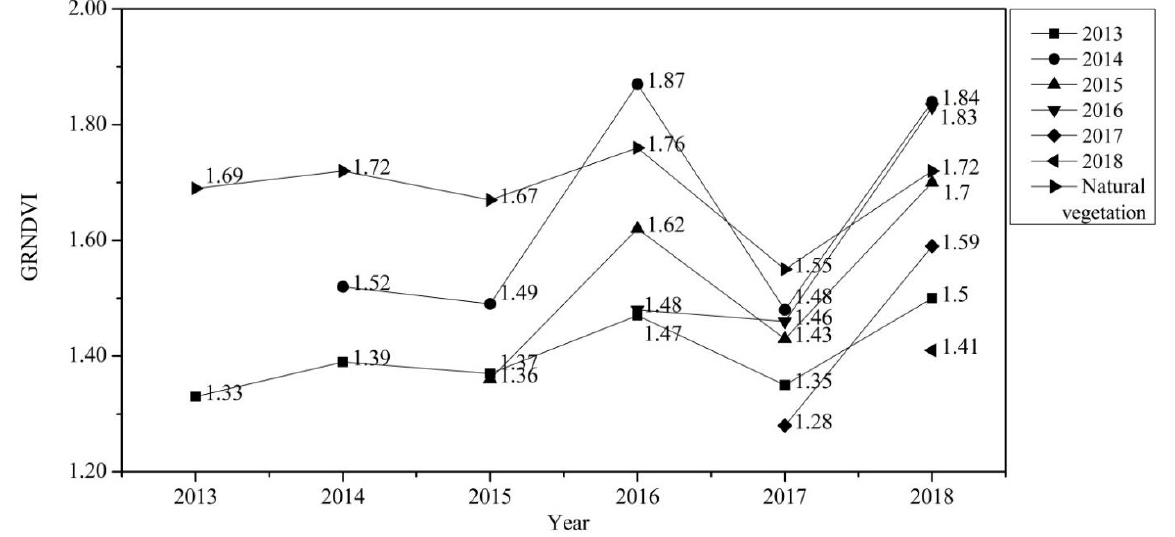
Figure 10. Comparison of the restoration and natural vegetation growths from 2013 to 2018 in the study region.